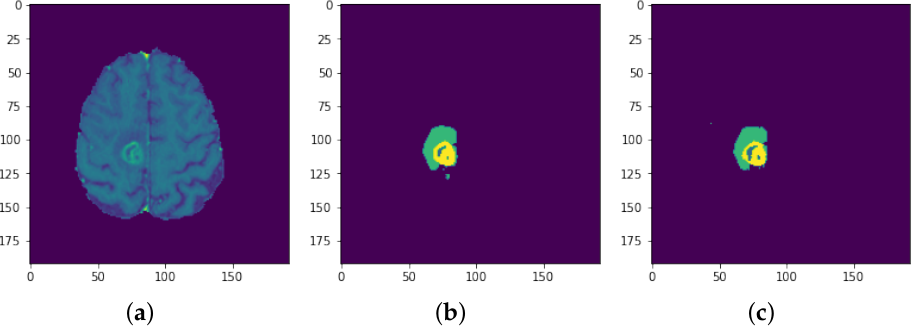
Figure 31. Results: Slice 4: ( a ) Slice ( b ) Predicted result ( c ) Actual result.